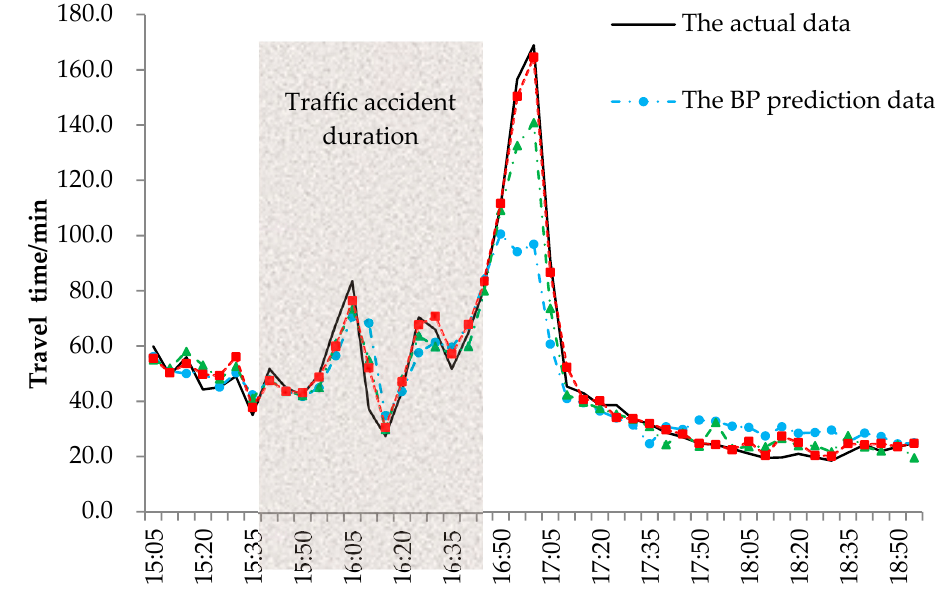
Figure 6. Travel time during traffic accident.